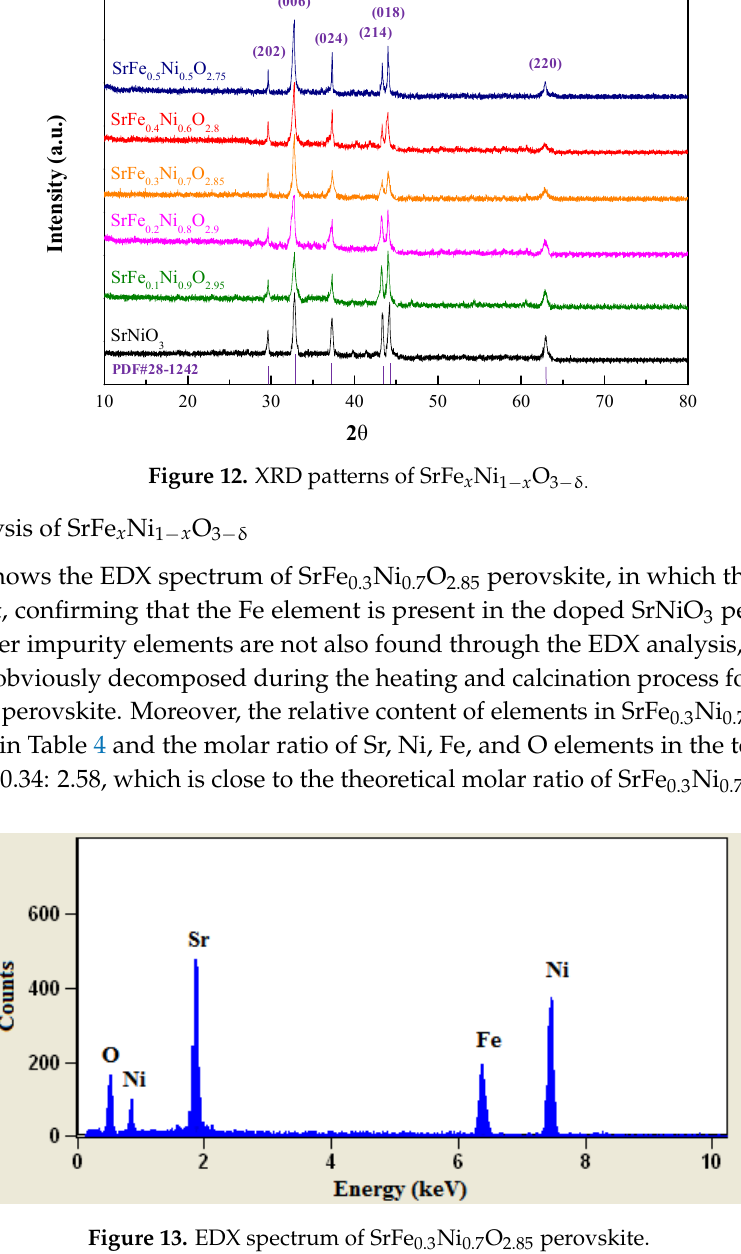
BO 6 Figure 11. FT-IR ( a ) and Raman ( b ) spectra of SrFe x Ni 1− x O 3−δ. 3.3.3. XRD Analysis of SrFe x Ni 1− x O 3−δ Further refined characterization of SrFe x Ni 1− x O 3−δ materials is conducted by XRD analysis in Figure 12. All the XRD diffraction peaks emerging at 29.6°, 32.8°, 37.3°, 44.1°, 43.4°, and 62.9° are sharp and intensive, certifying the brilliant crystallinity of SrFe x Ni 1− x O 3−δ materials. Above all, XRD patterns are featured with pure perovskite-type SrNiO 3 (PDF#28-1242) and the doping of Fe element does not change the single perovskite phase [43,44], which agrees with the FT-IR and Raman analysis. No diffraction peaks of Fe 2 O 3 , Fe 3 O 4 , NiO, SrO or other impurities can be observed in the XRD patterns, demonstrating that Fe element is successfully doped into the crystal lattice of